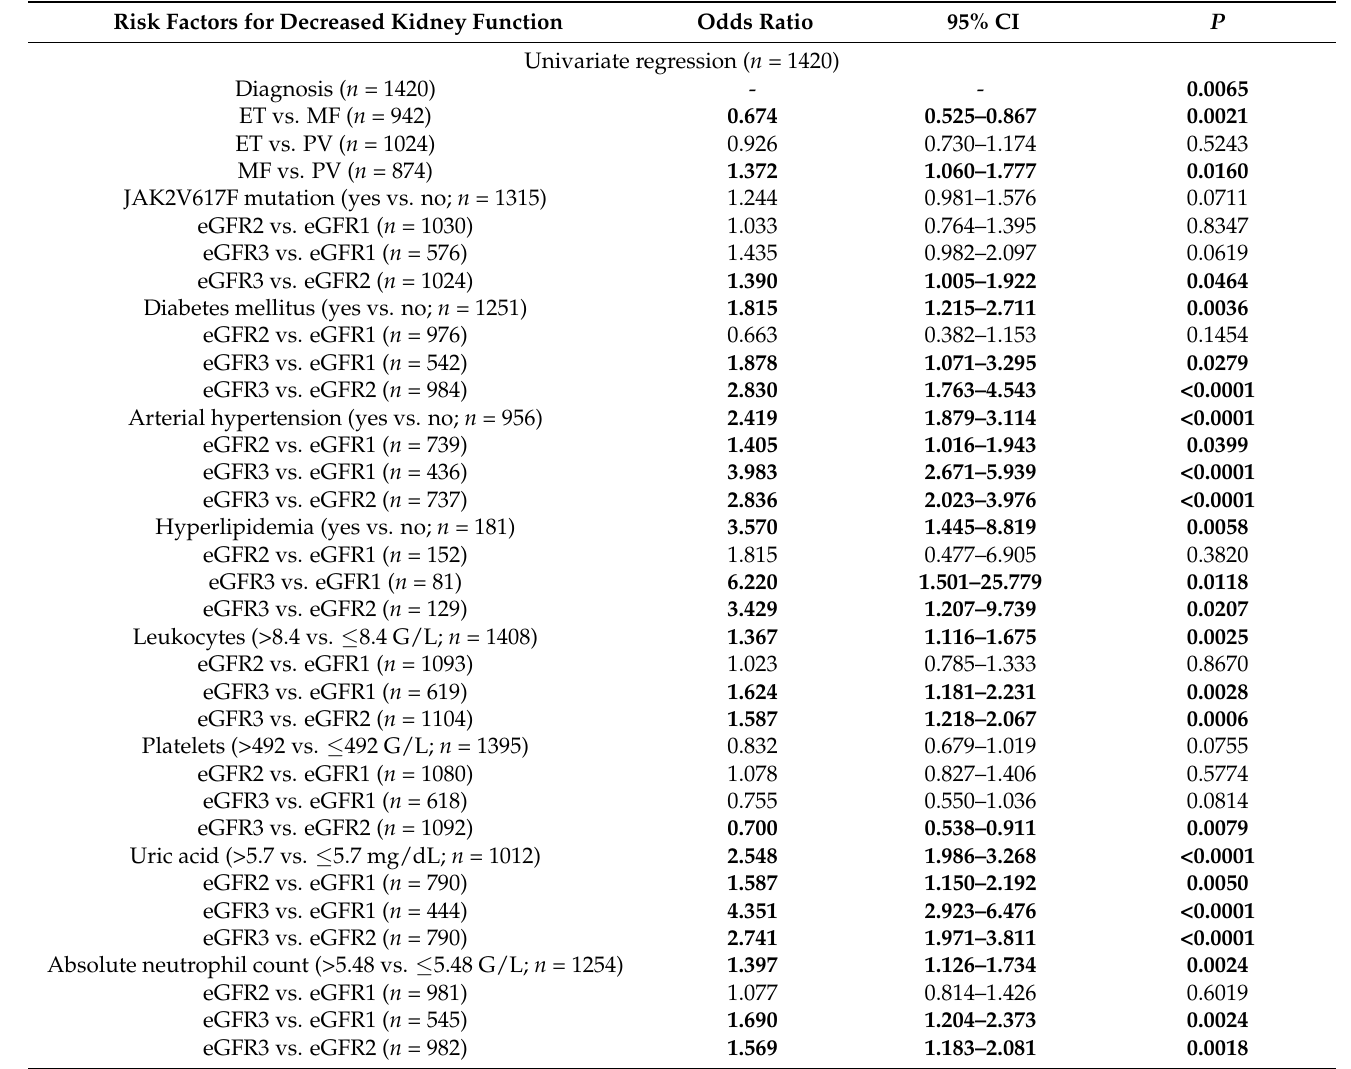
Table 2. Risk factors for decreased kidney function among all patients and eGFR